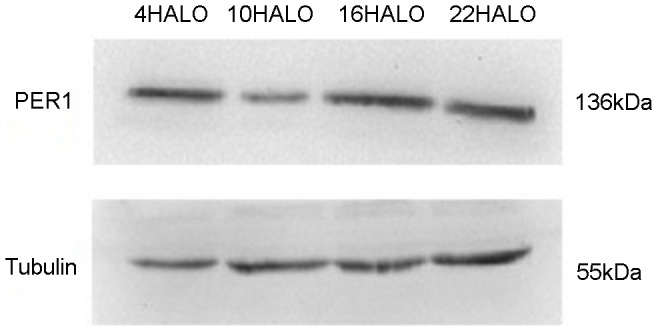
Western blot analyses of PER1 protein expressions of 4 time groups of tumor bearing mice.The level of Tubulin in each sample is detected as an internal control. One representative of three independent experiments with similar results is shown.